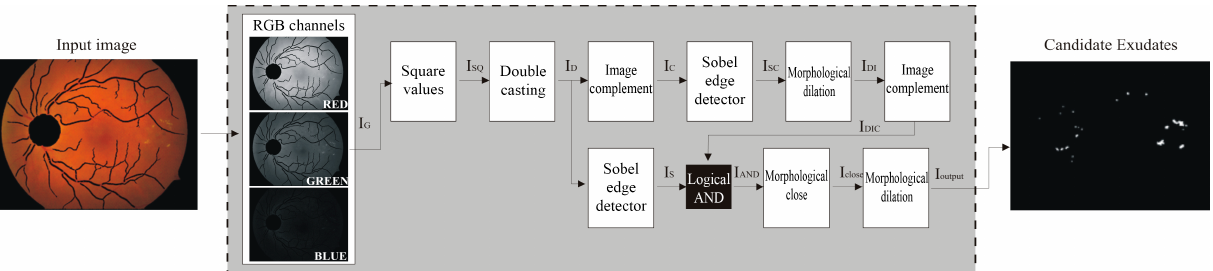
Figure 5. Main steps of the proposed algorithm.